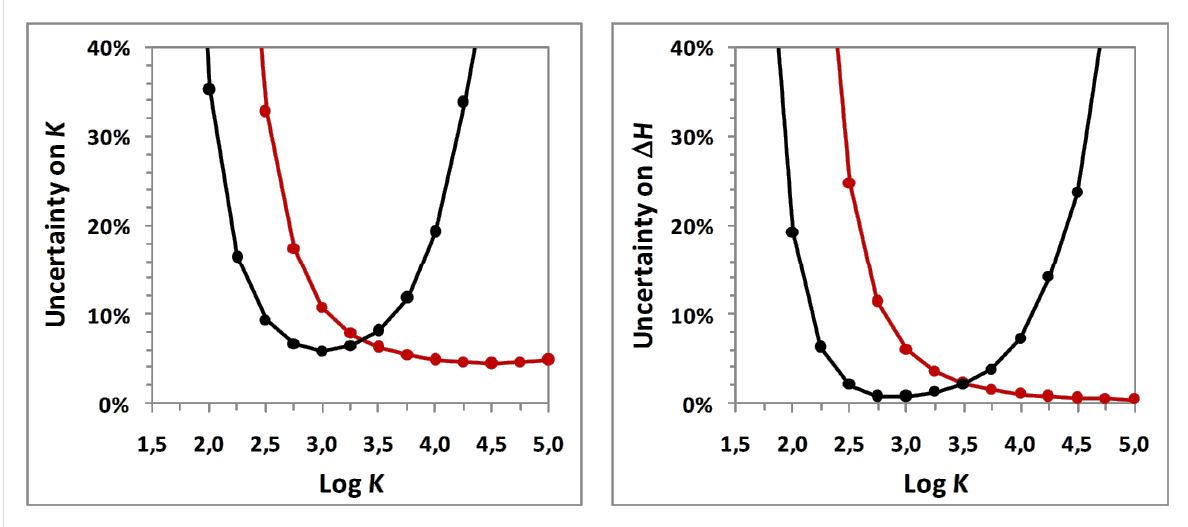
Figure 2: Theoretical uncertainty on K (left) and Δ H (right) as a function of log K for titration (red curve) and release (black curve) protocols given an aqueous guest solubility equal to 2 mM and for an inclusion enthalpy equal to − 3000 cal·mol − 1 .